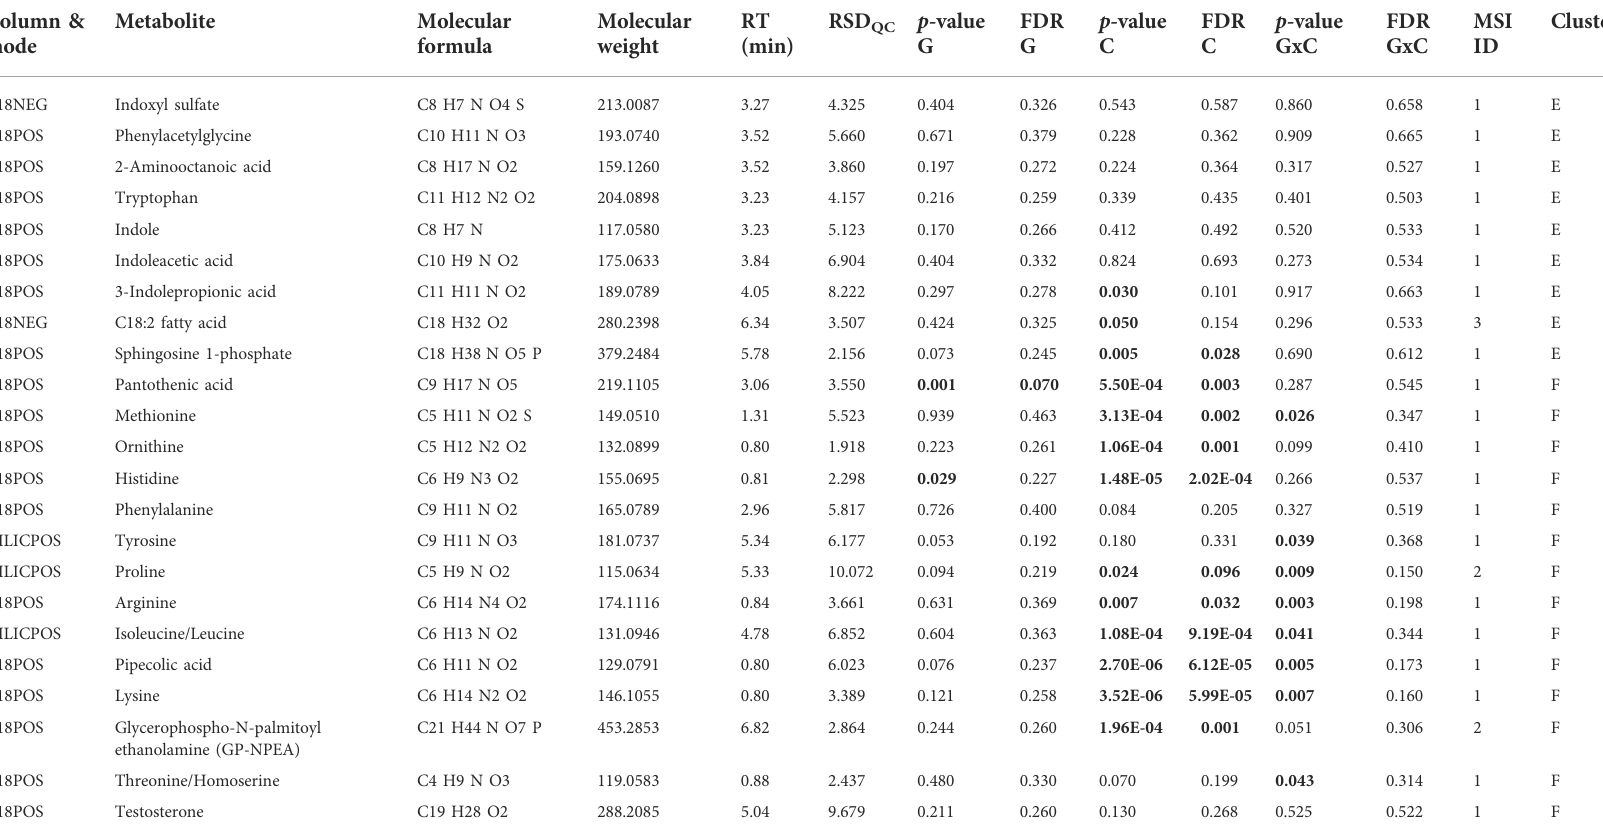
TABLE 1 ( Continued ) Summary of the metabolites identi fi ed/annotated from WT and DKI mouse plasma. A total of 83 plasma metabolites were identi fi ed/annotated, including 17 metabolites signi fi cantly changed by condition (i.e., exercise versus rest) and one metabolite signi fi cantly changed by genotype (i.e., DKI versus WT) based on univariate analysis. Statistically signi fi cant values ( p < 0.05